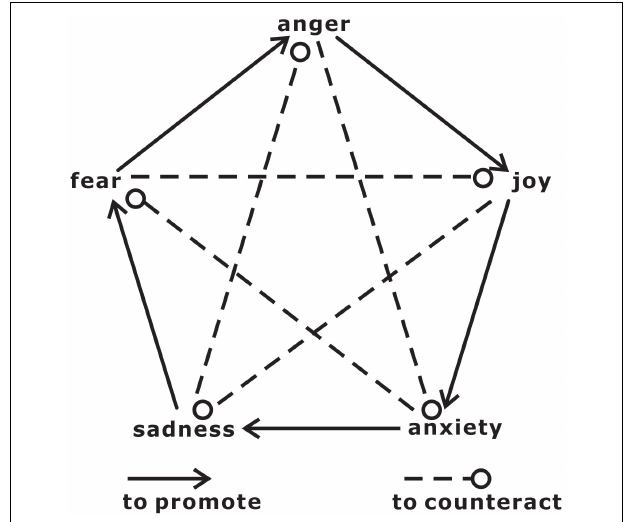
FIGURE 1 | The relationships between mutual promotion and mutual restraint and the emotions of joy, thinking/anxiety, sadness, fear, and anger. The promotion relationships include the following: joy promotes thinking/anxiety, thinking/anxiety promotes sadness, sadness promotes fear, fear promotes anger, and anger promotes joy. The restraint relationships include the following: joy counteracts sadness, sadness counteracts anger, anger counteracts thinking/anxiety, thinking/anxiety counteracts fear, and fear counteracts joy.